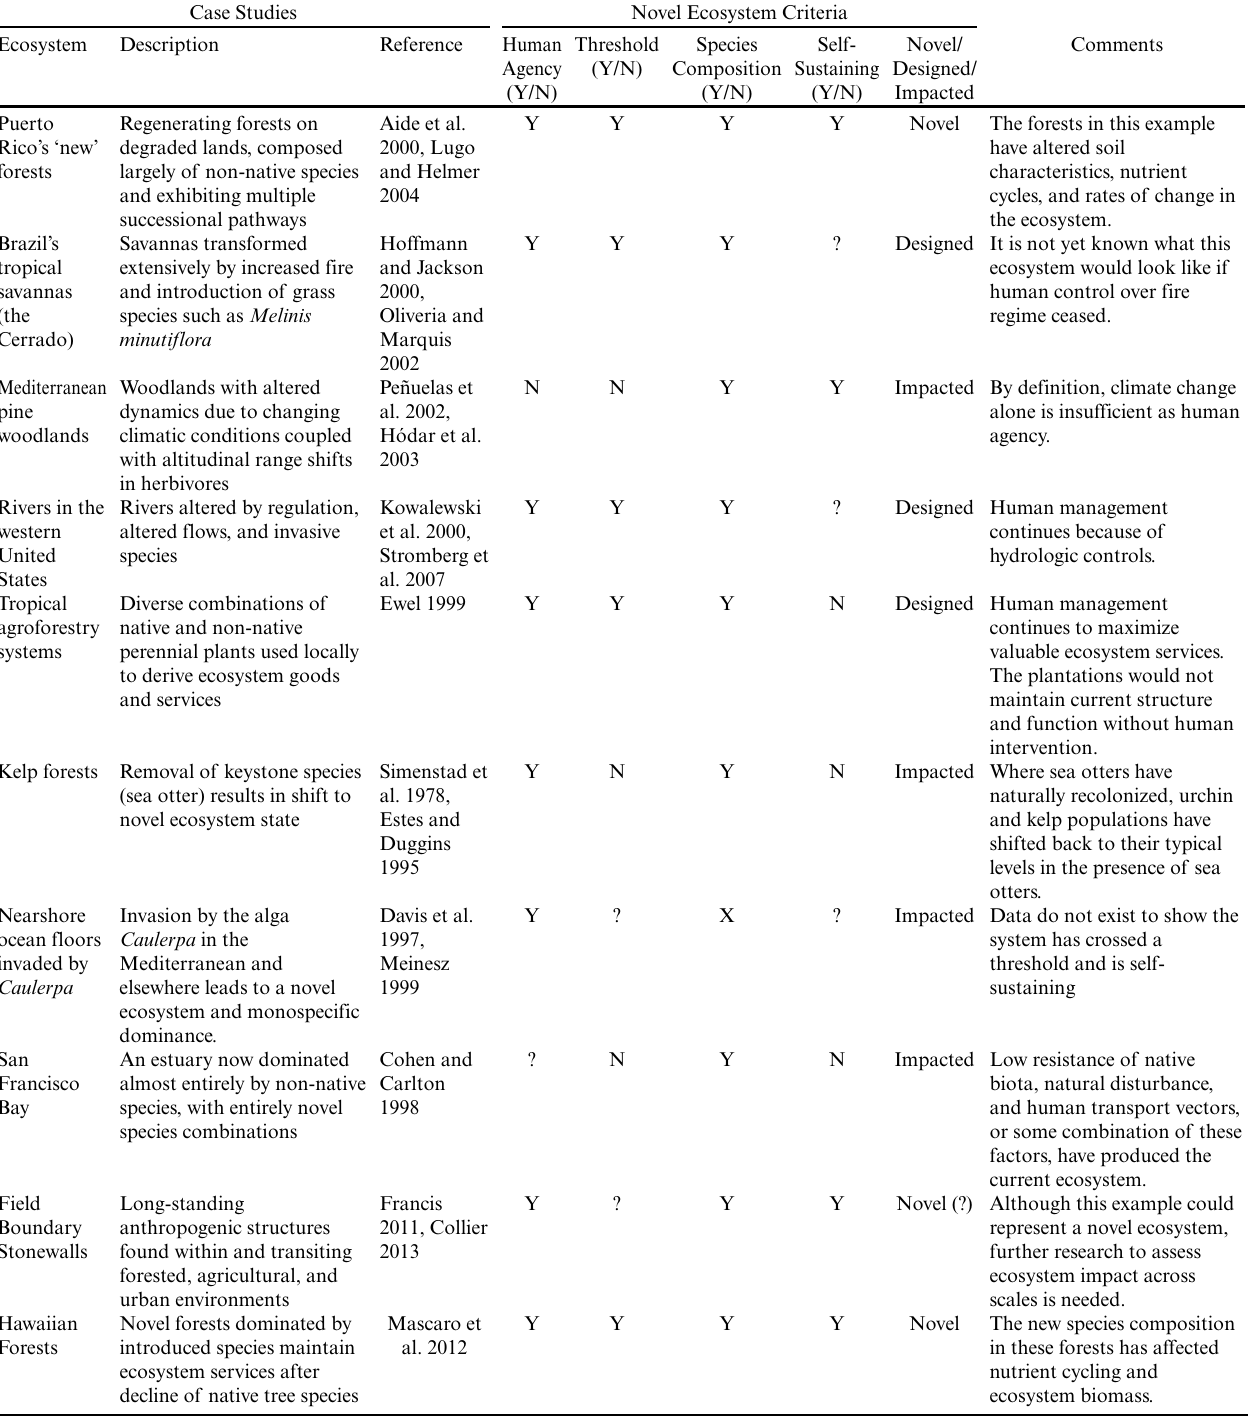
Table 1 . Examples of ecosystems that have been previously classified as novel in the literature. Each case study was designated as novel, designed, or impacted using the definition and four criteria outlined in this